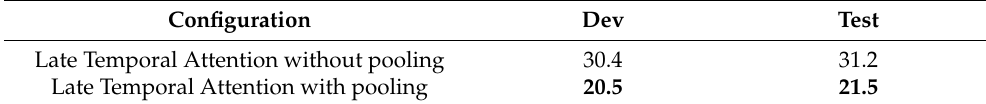
Table 3. WER Performance comparison using different late temporal attention configuration.